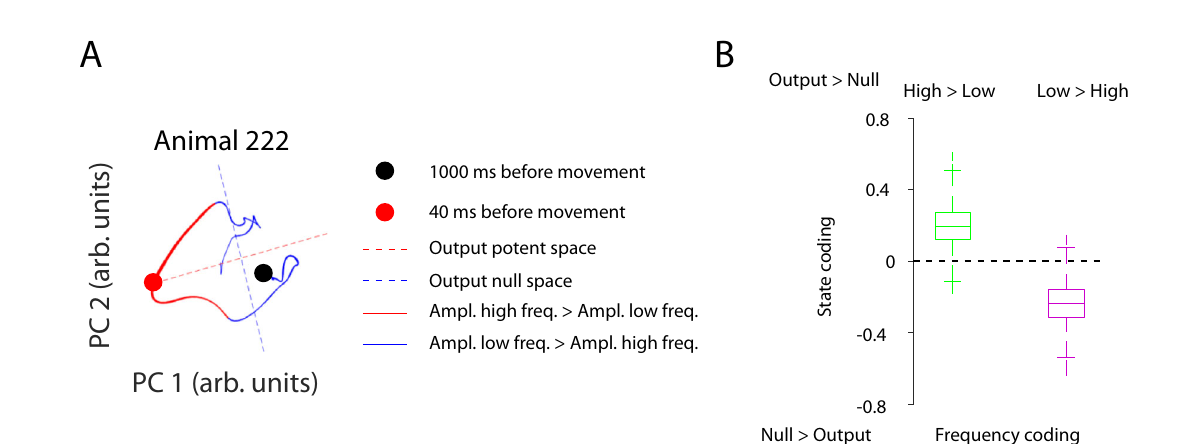
Fig. 5 Optimal frequency for decoding behavior. A Higher neural frequencies predict paw velocities better than lower frequencies. Original paw velocity in the locomotor task (1). Decoded paw velocity using low (2) and high (3) neural frequencies. The gray curves depict movements in the lateral-medial (LM) direction, black curves refer to movements in the anterior-posterior direction (AP). B Indicates the same as panel A , but for the joystick task. C , D Decoding performance is dependent on the neural frequencies for the locomotor task ( C ) and joystick task ( D ) and peaks at 2.3 Hz. To minimize a noise-dependent bias for low frequencies, we decoded the de-noised (encoded) neuronal activity (light-blue line). When we added White Gaussian noise to the de-noised neuronal activity (orange line) this accurately resembled the original neuronal data (yellow line). E , F Neuronal frequency increases before movement onset. Average wavelet analysis across decoding kernels for all sorted units for the locomotor ( E ) and joystick task ( F ). The amplitude of higher frequencies increases (black line) when approaching the time of movement at lag 0. Top inset: The averaged variability of the decoded kernel across all sorted units measured by bootstrapping across 10-s segments. G The amplitude for high frequencies is signi fi cantly higher for the joystick task than for the locomotor task. The ratio between the wavelet amplitude of the joystick and the locomotor task is plotted against neuronal frequency. Individual lines are bootstrapped data to show the statistics of the mean. Signi fi cances are indicated according to the frequency region for which p < 0.05 (*). Corrected for multiple comparisons. H The fastest changes in the unit-speci fi c decoding kernel are more focused in time for the joystick task than for the locomotor task. The time point of the largest recti fi ed temporal derivative of the decoding kernels of all sorted units for the locomotor task (blue) and for the joystick task (red). I Decoding kernels with a signal-to-noise ratio larger than fi ve. The decoding kernels were normalized to have standard deviations equal to 1. J Population activity is more synchronized during the joystick task than during the locomotor task. Latency variability of the full-width half maximum (or minimum) of the unit-speci fi c decoding kernels for the locomotor task (blue) and for the joystick task (red). Two-sided bootstrap corrected for the dependency across sessions (see methods) of the difference of the standard deviation: p = 0.011 (Locomotor task: n = 57, Joystick task: n = 110). The data for each box-plot is bootstrapped and corrected for dependence across sessions (see methods). Box-plots: central mark indicates the median, bottom, and top edges refer to the 25th and 75th percentiles. Signi fi cances are indicated according to * p < 0.05. K – L Illustration of how low temporal jitter across individual neurons may conserve high frequency while a high jitter leads to a low frequency. Source data are provided as a Source Data fi le.